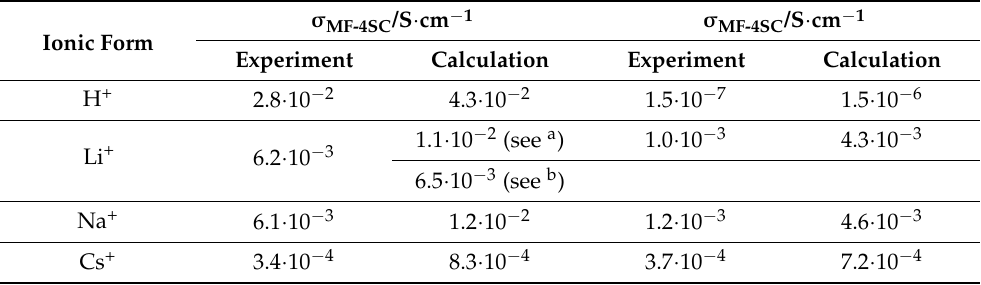
Table 6. Ionic conductivities calculated based on diffusion coefficients of water and Li + cations and measured for MF-4SC and F-4CF membranes in different ionic forms at the relative humidity of 90% [30]. Ionic